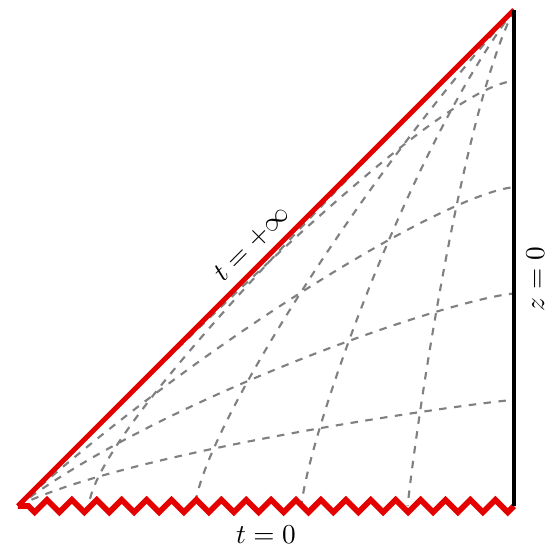
Figure 1 . Penrose diagram of the ( t; z )-projection of Kasner-AdS for t > 0. Horizontal (vertical) dashed lines are constant t (constant z ). The diagram for t < 0 is just the t ! (cid:0) t